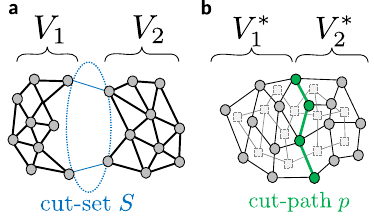
Fig. 3 | Geometry of primal and dual community boundaries. a Decomposition of a graph into two primal communities. Some edges belong to neither of the two communities, but provide a weak connection between the communities. These edgesconstitutethecut-set S . b Agraph(blacksolidlines)anditsdual(graydashed lines), which is decomposed into two communities V * 1,2 . Some primal edges, colored in green, belong to faces from both communities. These primal edges, together with their terminal nodes, constitute the cut-path p .